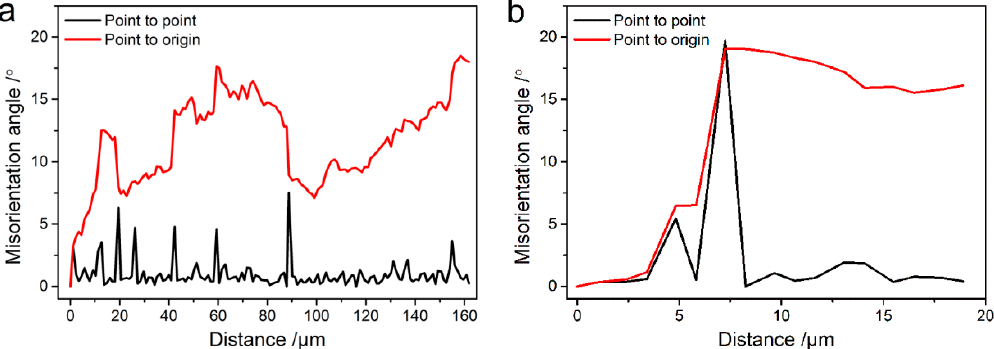
Figure 7. Misorientation profiles obtained along the lines marked in Figure 6a. ( a ) L1; ( b ) L2.